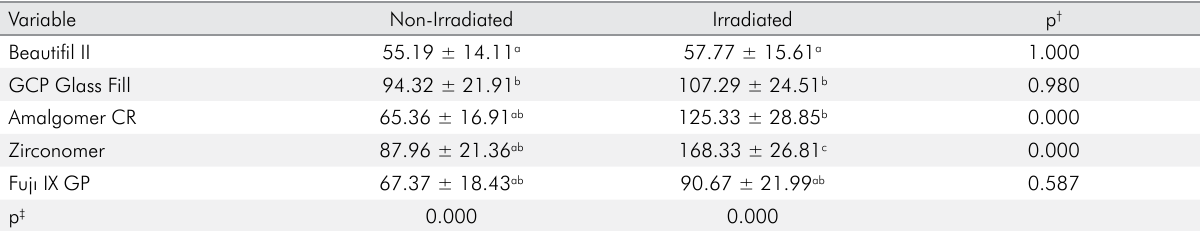
Table 3. Mean and standard deviation values of surface roughness ( η m) of the materials. Variable